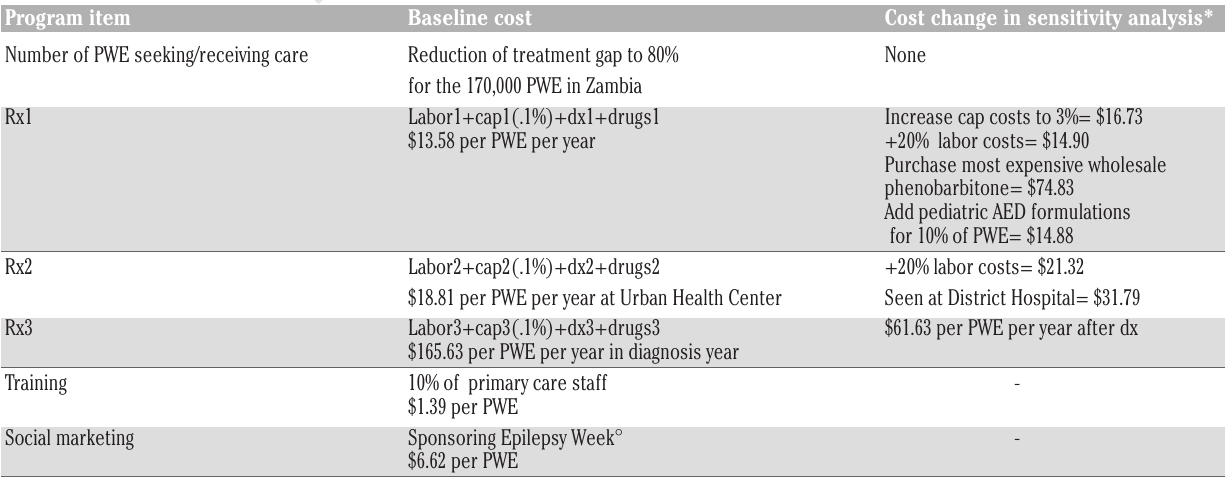
Table 3. Costs of an epilepsy care program aimed at decreasing the treatment gap from 90-80%. Program